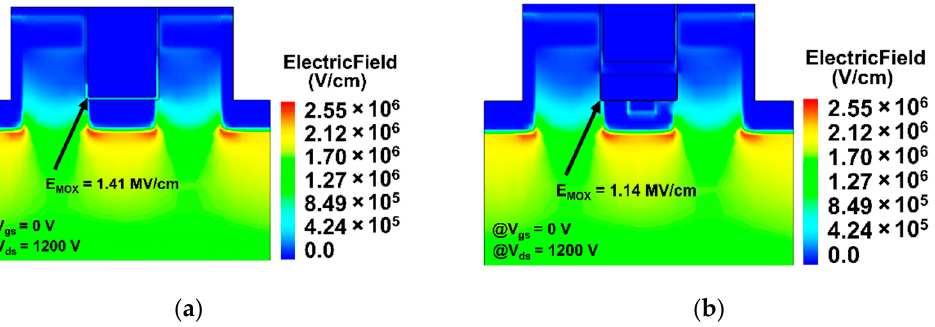
Figure 8. Cross-sectional view of the electric field distribution of ( a ) DT-MOSFET and ( b ) DTMCD- MOSFET at V DS = 1200 V.